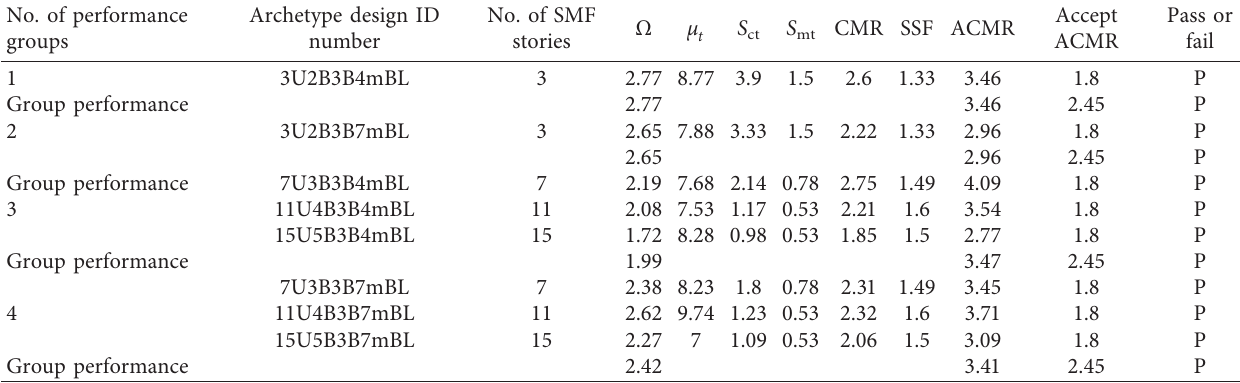
Table 2: Collapse performance evaluation of RCT archetypes.